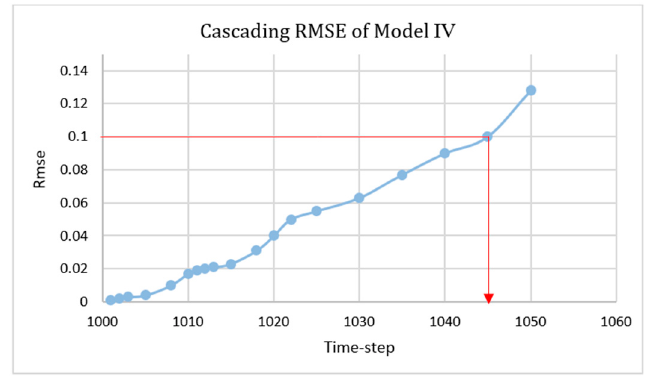
Figure 41. Root mean square equation (RMSE) of the cascading condition for Model IV.